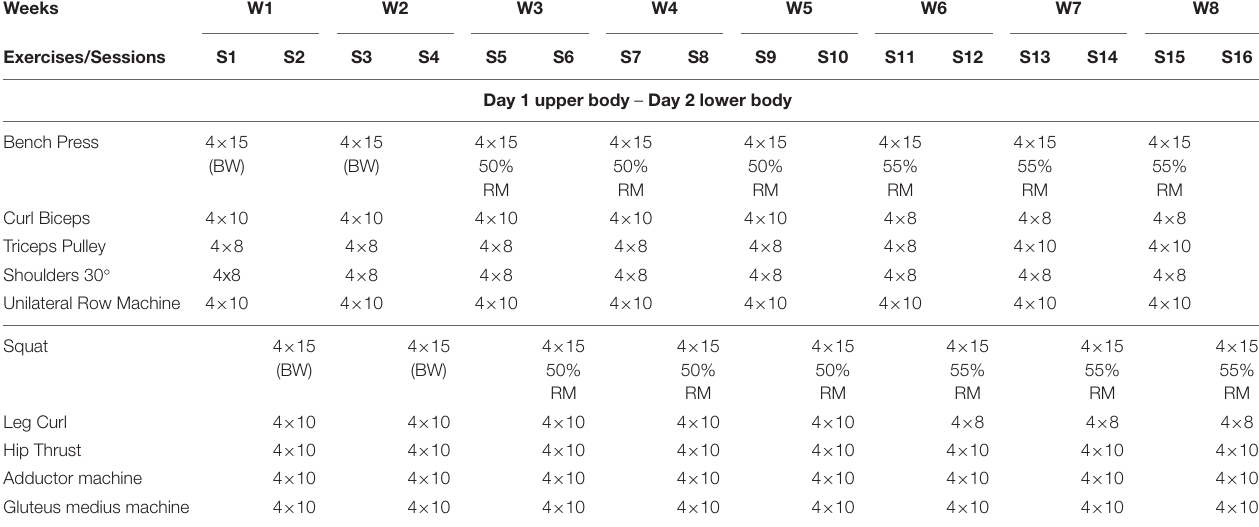
TABLE 2 | Phase 1(A): Overload treatment.